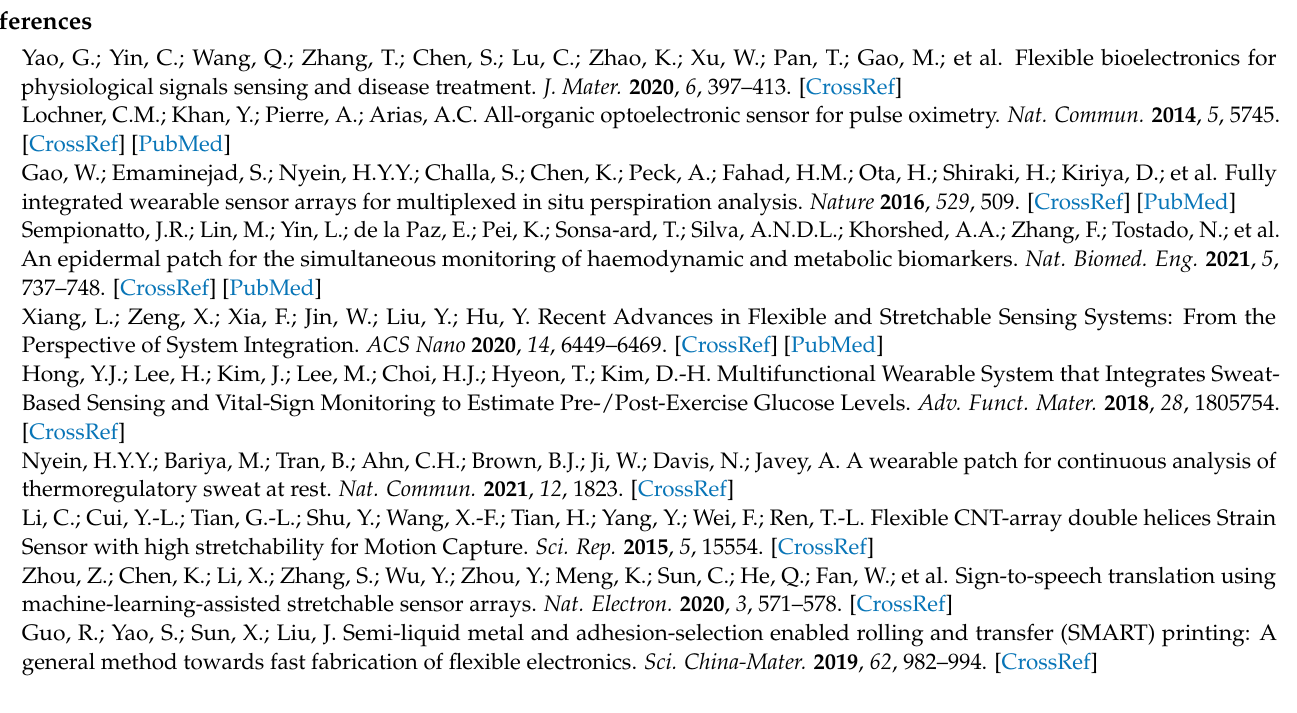
hollow circuit pattern, Figure S2: Thin film of polyethylene terephthalate (PET) with specific sensor pattern used for the fabrication of the strain sensor, Figure S3: Illustration of resistance-uniaxial tensile strain measurement, Figure S4: Characterize the relationship between resistance change and deformation of liquid metal traces on flexible substrates by using a tensile measuring instrument, Figure S5: The physical diagram and schematic diagram of the NFC tag module, Figure S6: Physical photo of the NFC reader testing platform, Figure S7: An example of the patch detecting the bending motion of the index finger and interacting with the external NFC